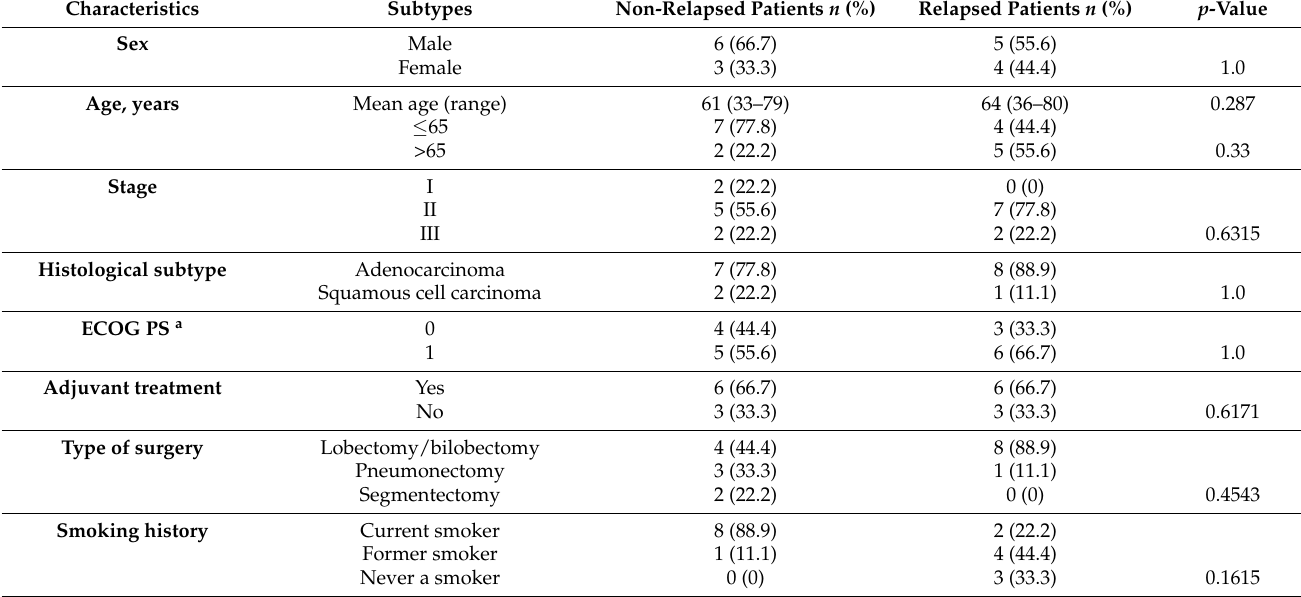
Table 1. Main clinical characteristics of screening cohort ( n = 18) grouped by relapse status. The p -value was calculated using Fisher’s exact test or chi-squared, except for age, where a t-test was used. No significant differences were observed between the two groups of